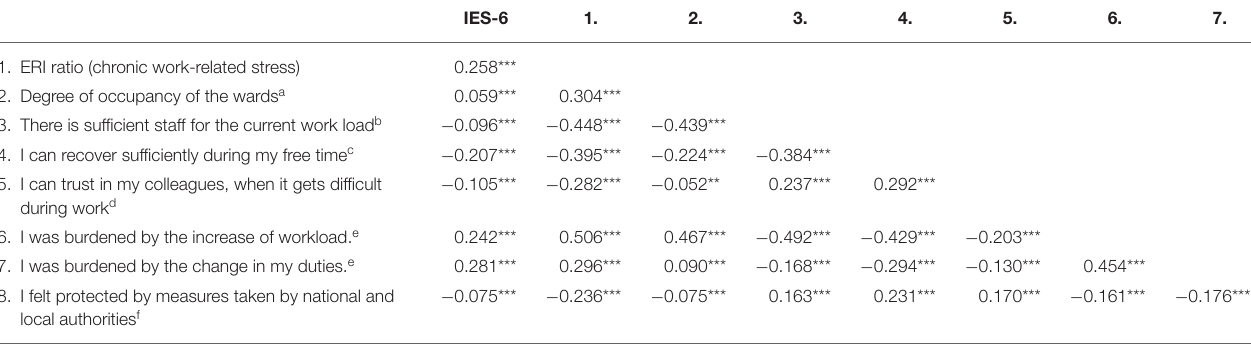
TABLE 4 | Correlations of PTSD symptoms with work-related characteristics during the COVID-19 pandemic among the sample of healthcare workers ( N =